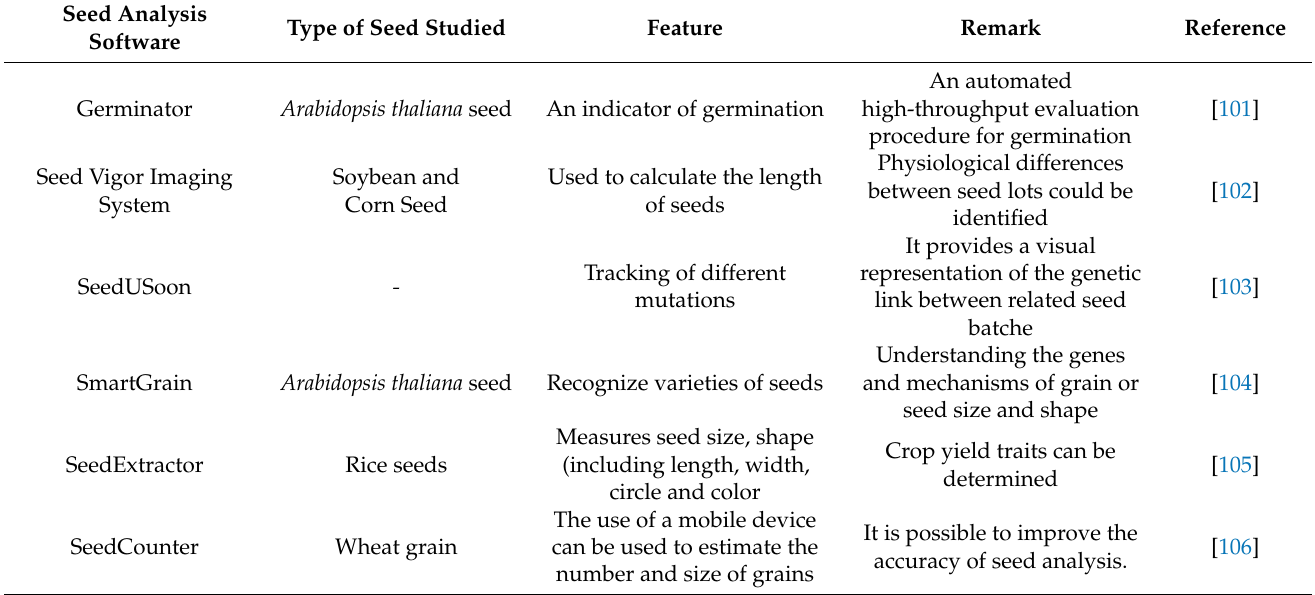
Table 2. Software that processes images simultaneously and produces accurate analyses of seedling germination and establishment. Using artificial neural networks, advanced computer-vision and machine-learning techniques have been applied to germination assays to assess the germination status of various nanoprimed